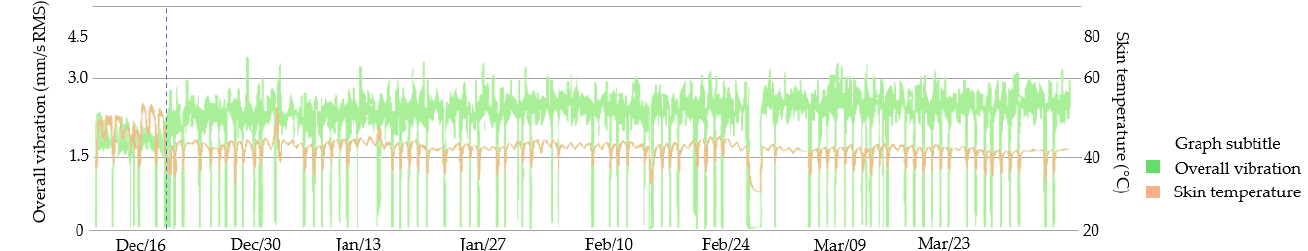
Figure 13. Motor 1 monitoring by the smart sensor.